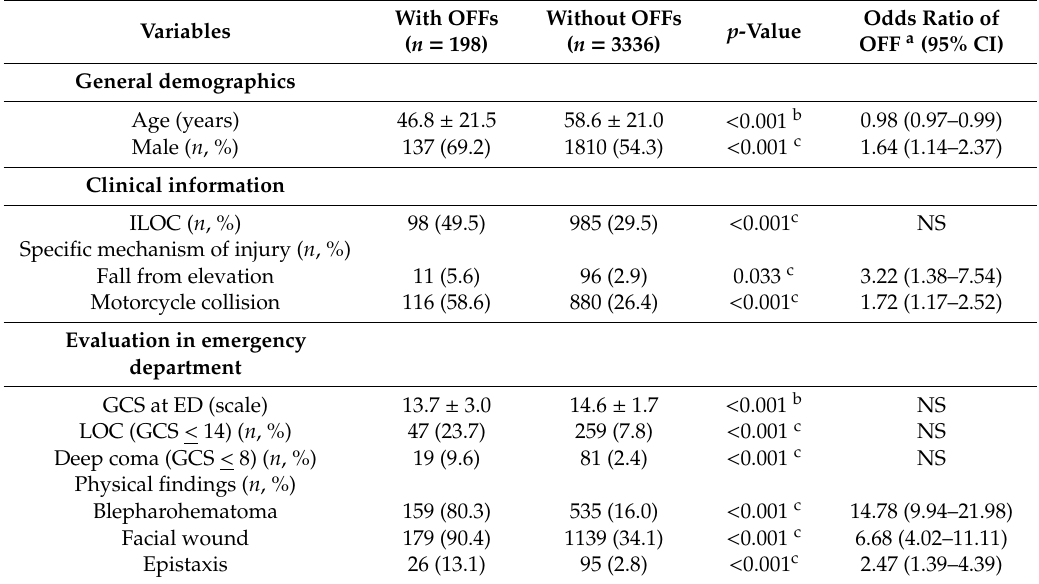
Values represent the mean ± SD. Abbreviations: CI, confidence interval; GCS, Glasgow Coma Scale; ILOC, initial loss of consciousness; IQR, interquartile range; LOC, loss of consciousness; NS, not significant; OFFs, orbital floor